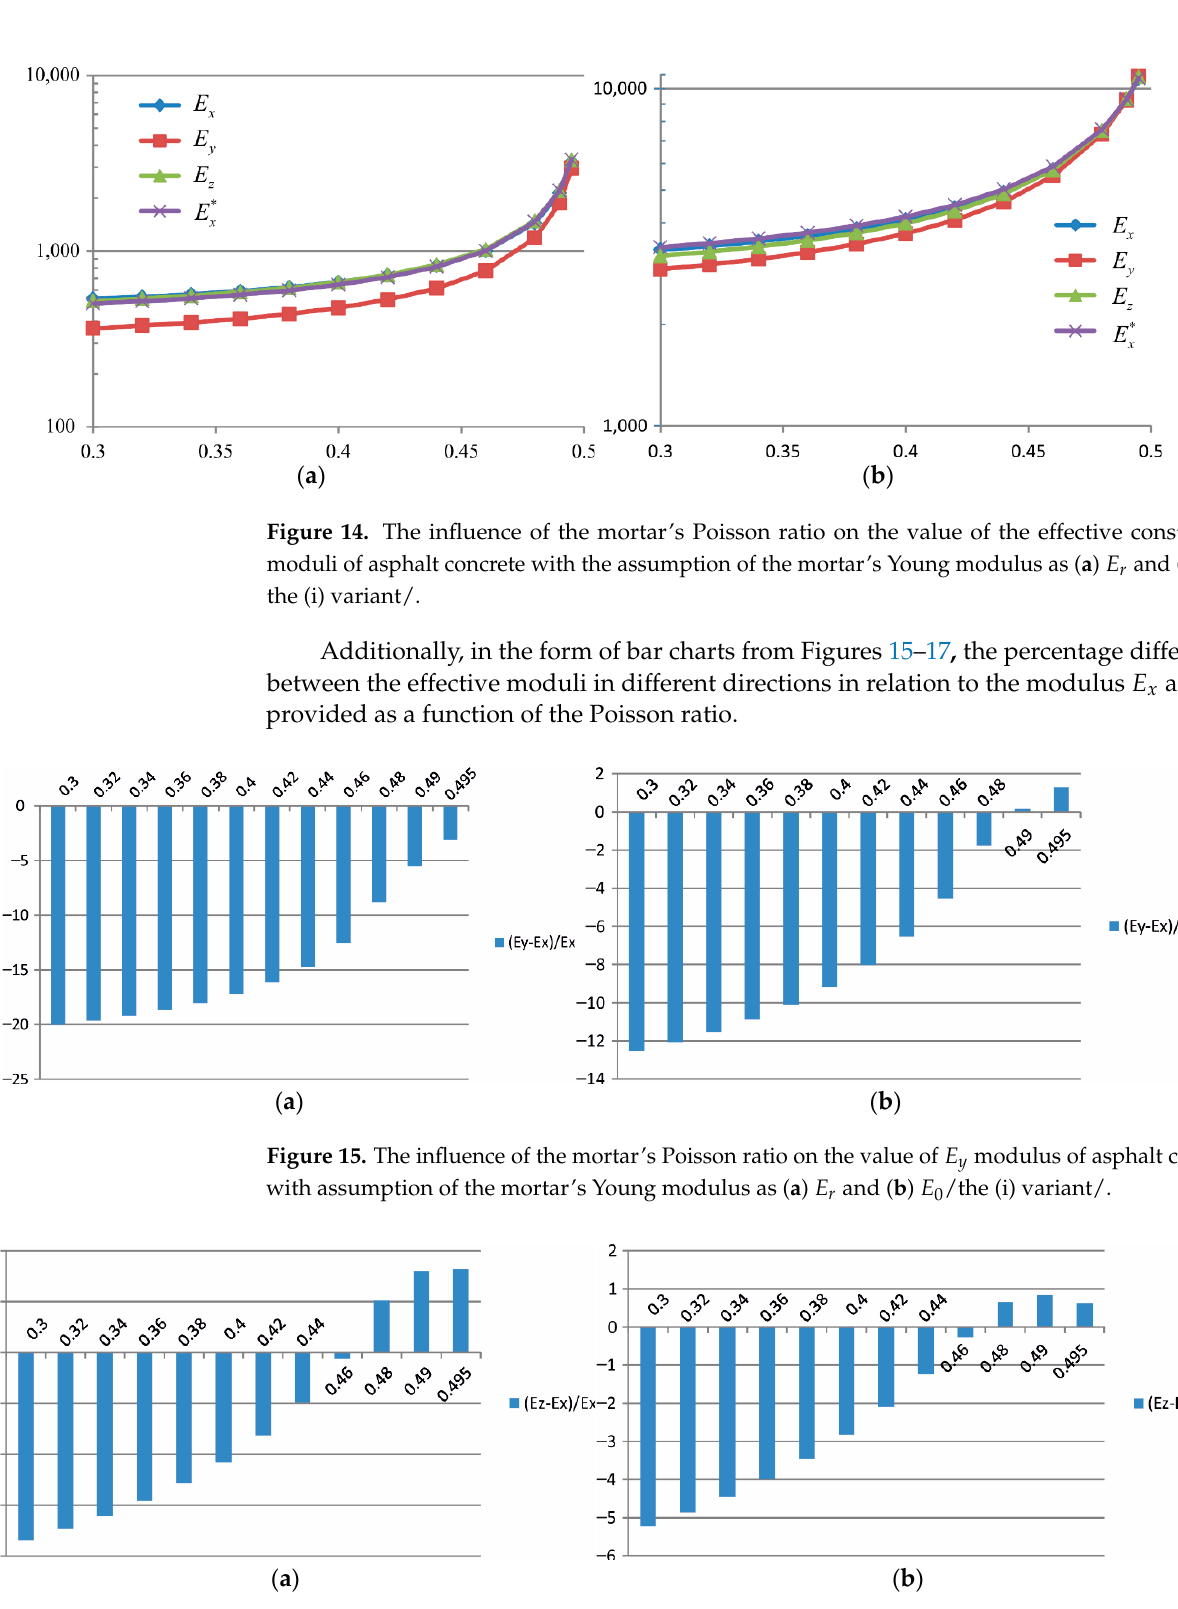
Figure 16. The influence of the mortar’s Poisson ratio on the value of E z modulus of asphalt concrete with the assumption of the mortar’s Young modulus as ( a ) E r and ( b ) E 0 /the (i)